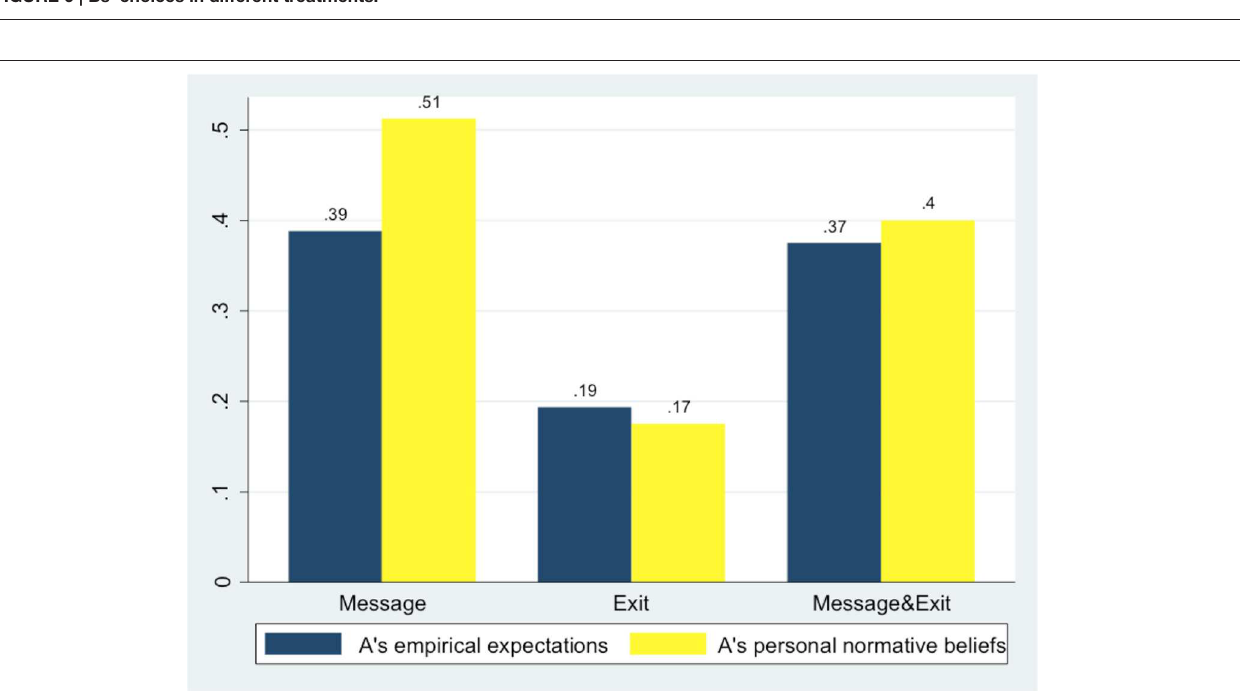
FIGURE 7 | A’s empirical expectation on B’s ROLL decisions and A’s personal normative